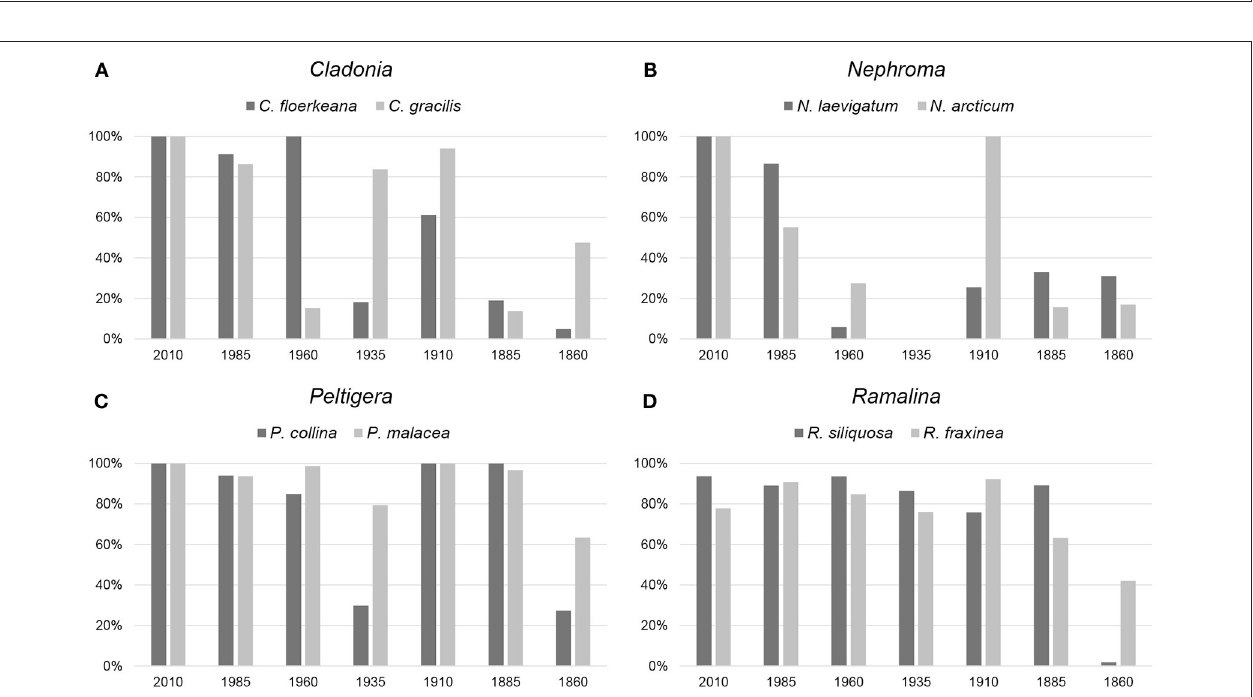
FIGURE 5 | Sequence recovery success per period for each specimen divided into the four chosen genera: (A) Cladonia , (B) Nephroma , (C) Peltigera , and (D) Ramalina .